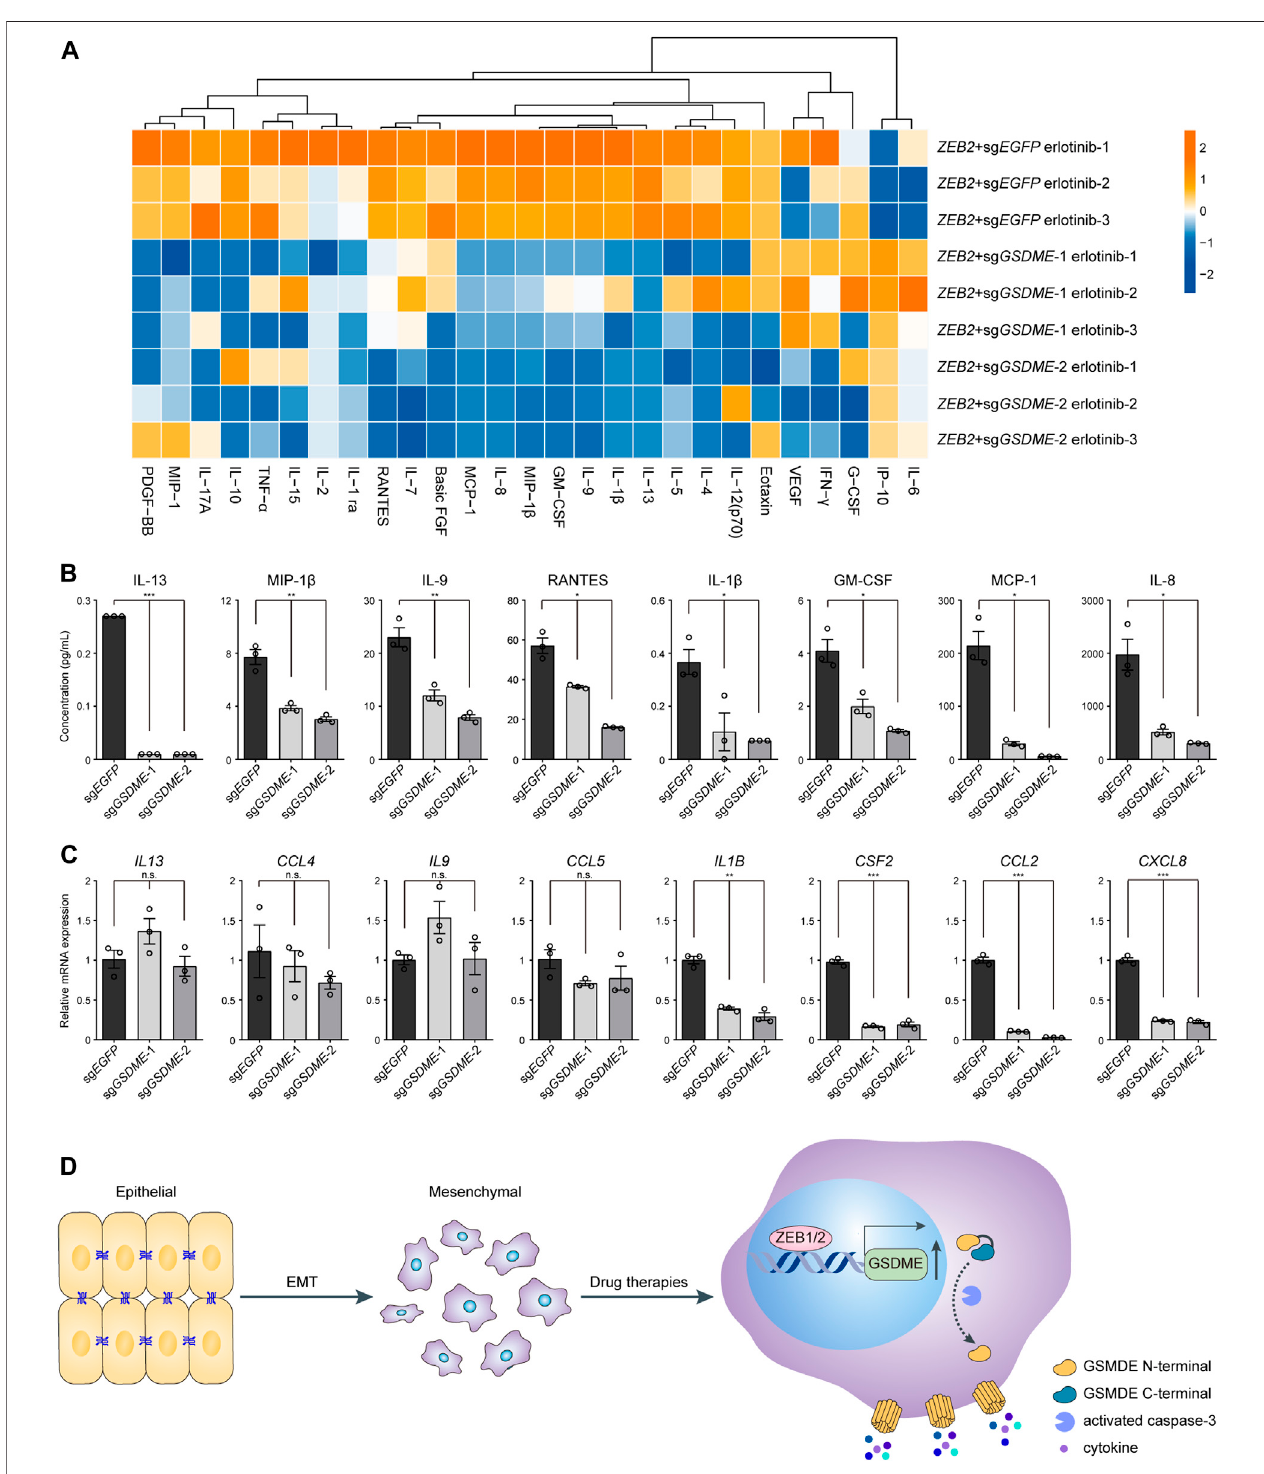
FIGURE 5 | GSDME-mediated cytokine release from mesenchymal cells. (A) GSDME was knocked out in HCC827 cells using the CRISPR-Cas9 system. Cells were transfected with exogenous ZEB2 to induce EMT, and treated with erlotinib (4 μ M) for 72 h. The secretion of 27 cytokines was analyzed by Luminex liquid suspension chip. (B) Concentrations of eight representative cytokines as measured by Luminex liquid suspension chip (* p < 0.05; ** p < 0.01; *** p < 0.001). Data are means ± SEM pooled from three independent experiments. (C) Gene expression levels of eight representative cytokines were analyzed by qPCR (n.s. not signi fi cant;* p < 0.05; ** p < 0.01;*** p < 0.001).Dataaremeans ± SEMpooled fromthreeindependent experiments. (D) Aschematicsummaryofthestudyshowingthat EMT-TFsZEB1 and ZEB2 induce GSDME transcriptionalactivation inmesenchymaltumor cells, leadingtoin fl ammatorypyroptosis withcytokinereleasein response to drug therapies.